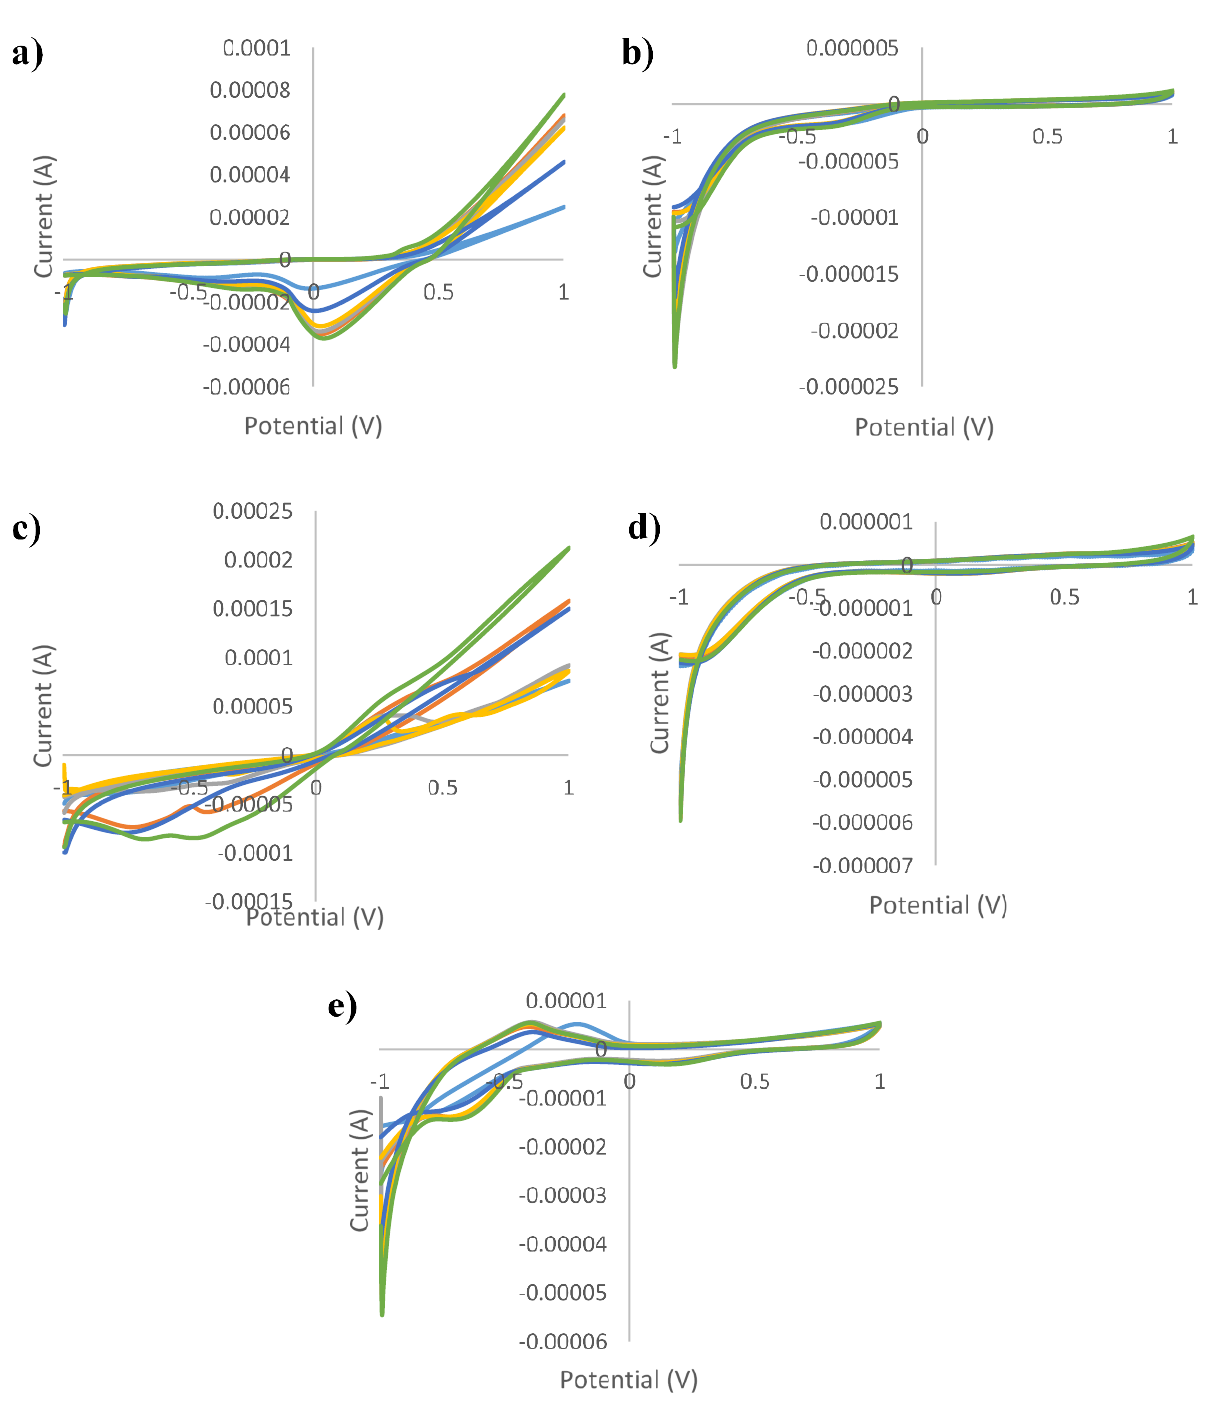
Figure 5. Cyclic voltammograms of authentic and adulterated (with inverted sugar syrup) tilia honey solutions for: ( a ) silver electrode; ( b ) gold electrode; ( c ) copper electrode; ( d ) glass electrode; ( e ) platinum electrode and green line—authentic honey; light blue line—agave syrup; red line—honey adulteration 5%; gray line—honey adulteration 10%; orange line—honey adulteration 20%; dark blue—honey adulteration 50%.